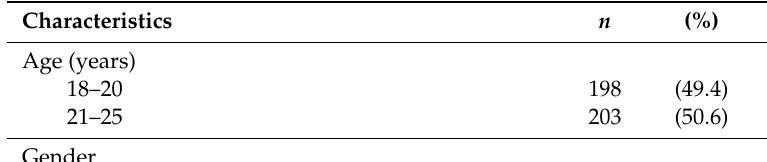
Table 1. Socio-demographic and physical characteristics of study participants ( n =